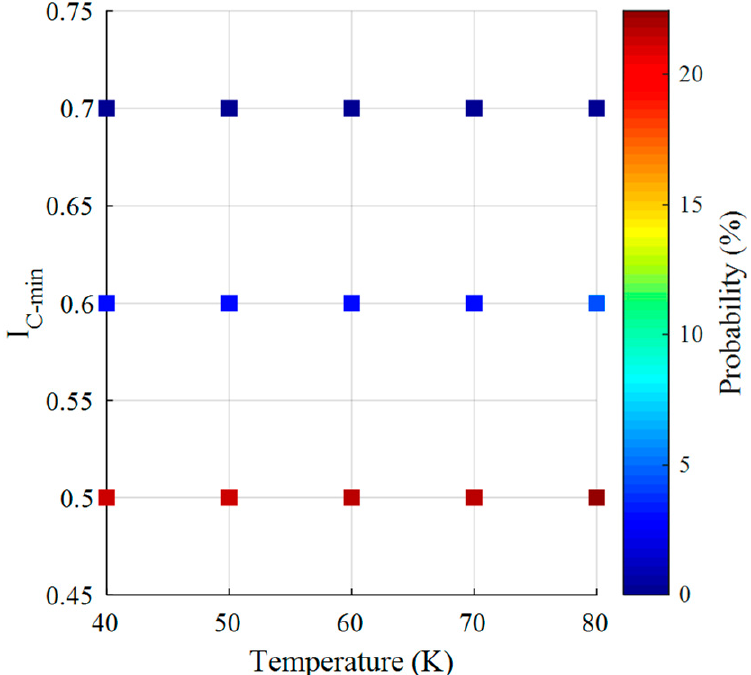
Figure 12. The impact of minimum critical current on the quench probability of Shanghai Creative Superconductor HTS